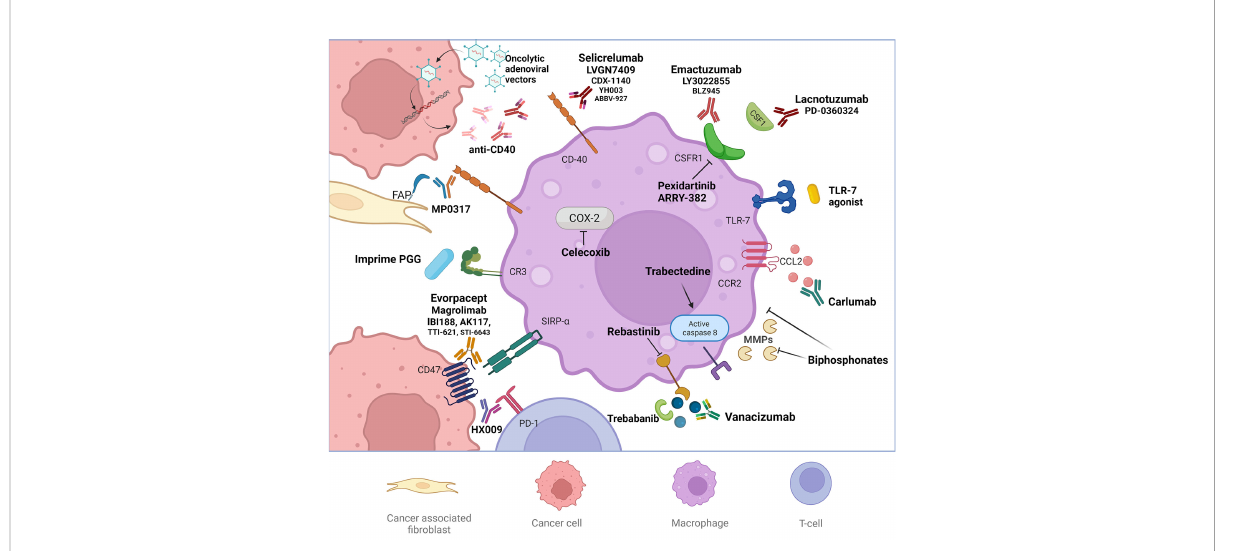
FIGURE 2 Macrophage-targeted treatment strategies on study. Macrophage-targeted treatment strategies include: inhibition of macrophage and macrophage precursors recruitment targeting the CSF1-CSFR and CCL2-CCR2 pathways, depletion of tumor associated macrophages (TAMs) (like biphosphonates), repolarization of TAMs to an antitumor phenotype, inhibition of tumorigenic factors and mechanisms promoted by TAM and enhancement of macrophage-mediated tumor cell killing or phagocytosis. The repolarization of TAMs is mediated by stimulating the costimulatory receptor CD40, Toll-like receptor 7 (TLR7) or administrating anti-CD47 drugs. Anti CR3 factors enhance the innate activity of macrophages, favoring the antitumoral phenotypes. Ang2 and the respective receptor TIE2 constitute another druggable pathway favoring antitumor responses and inhibiting the functions of